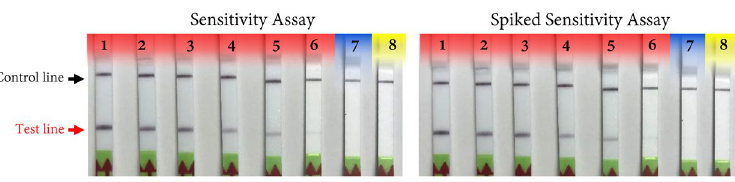
Figure 6. Sensitivity and spiked sensitivity of the developed RPA assay using a 10-fold serially diluted genomic DNA of Pectobacterium carotovorum subsp. carotovorum (strain A5280). In the spiked sensitivity assay, 1 µ l (59 ng/ul) of host genomic DNA was added to each serially diluted genomic DNA sample to confirm the lack of an inhibitory effect of host genomic DNA on the RPA assay detection limit. No difference in sensitivity between spiked and non-spiked samples was observed. Lanes 1 to 7 are serially diluted genomic DNA (1 ng to 1 fg), and line 8 is non-template control